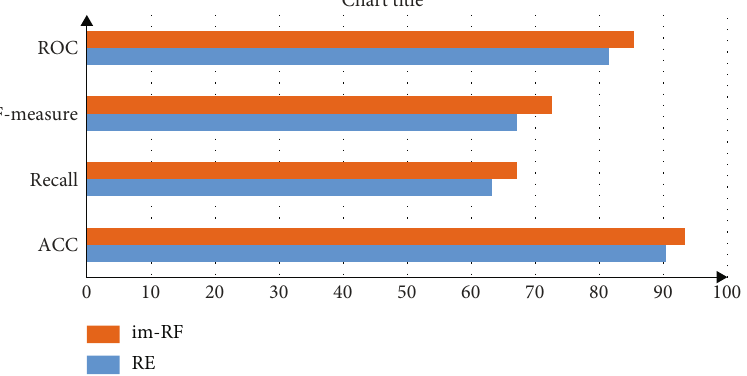
Figure 4: E ff ect of weight improvement on algorithm